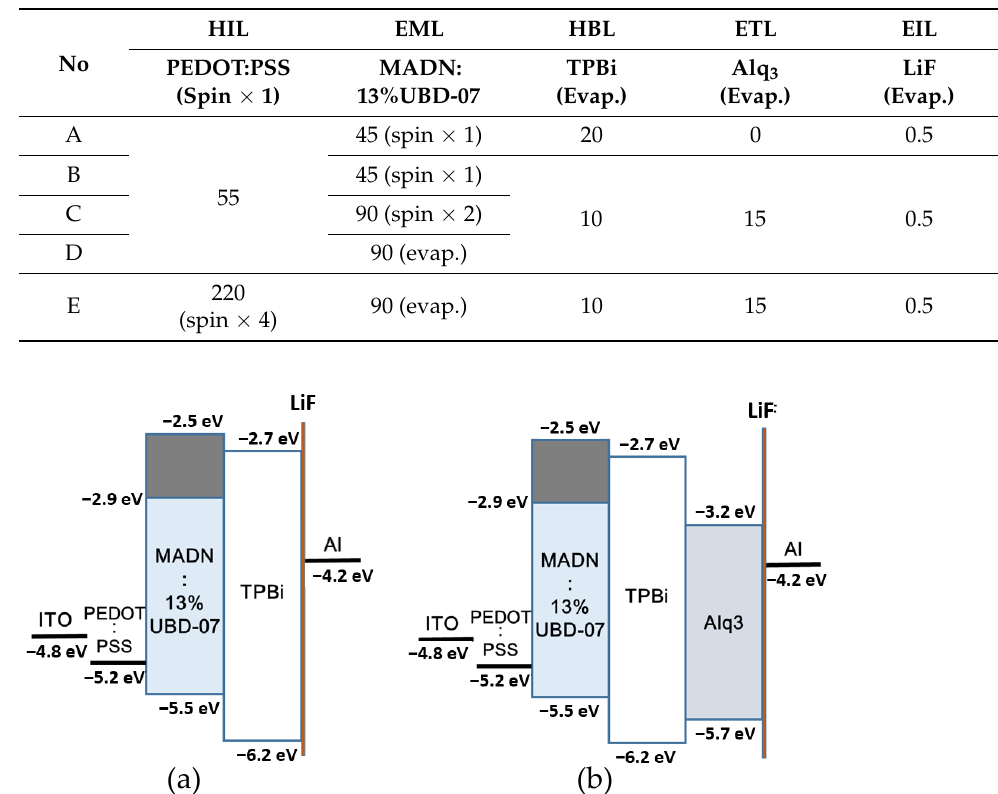
Figure 2. Band diagram of ( a ) adding a HIL PEDOT:PSS, ( b ) adding an ETL Alq 3 , where light blue region is the energy band of dopant .